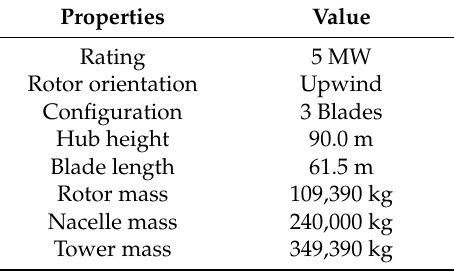
Table 1. Key parameters of the components of the National Renewable Energy Laboratory (NREL) 5 MW wind